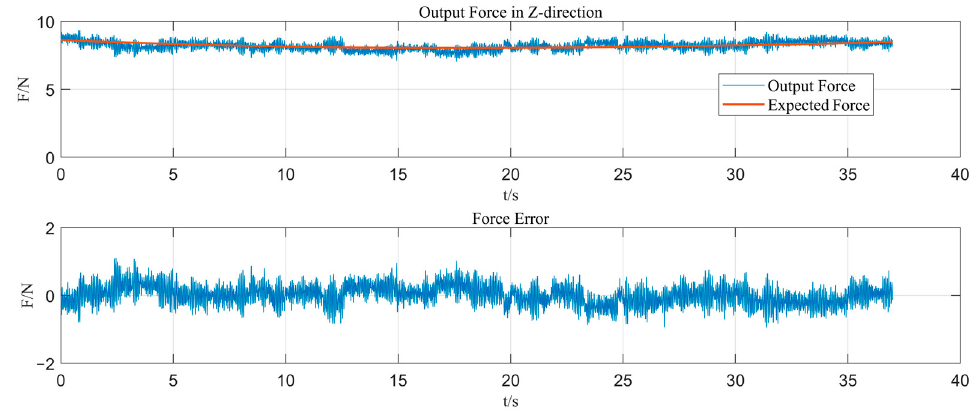
Figure 15. Response curve of output force on a single path with Fuzzy-RBF-PID control.